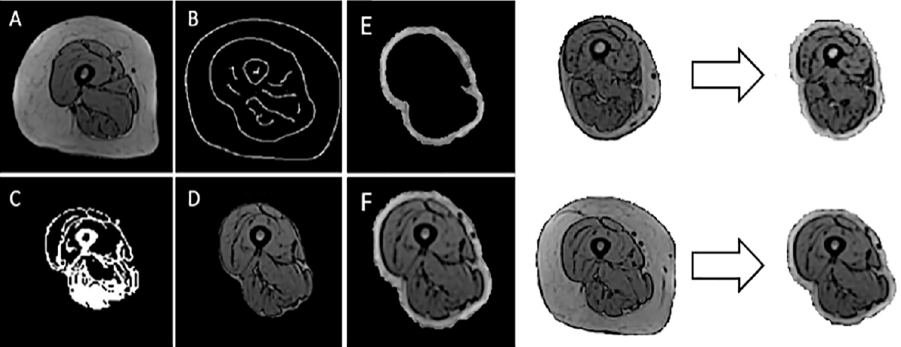
Fig 1. Homogenisation of the fat tissue surrounding the muscles. The process of masking the fat tissue surrounding the muscles from the raw MR images (left) and wrapping in a homogenous layer of fat for two images taken from different subjects (right). The subject along the top row (right) had a fat layer less that 5 mm thick and was wrapped with artificial fat, where the subject along the bottom row had a depth that was